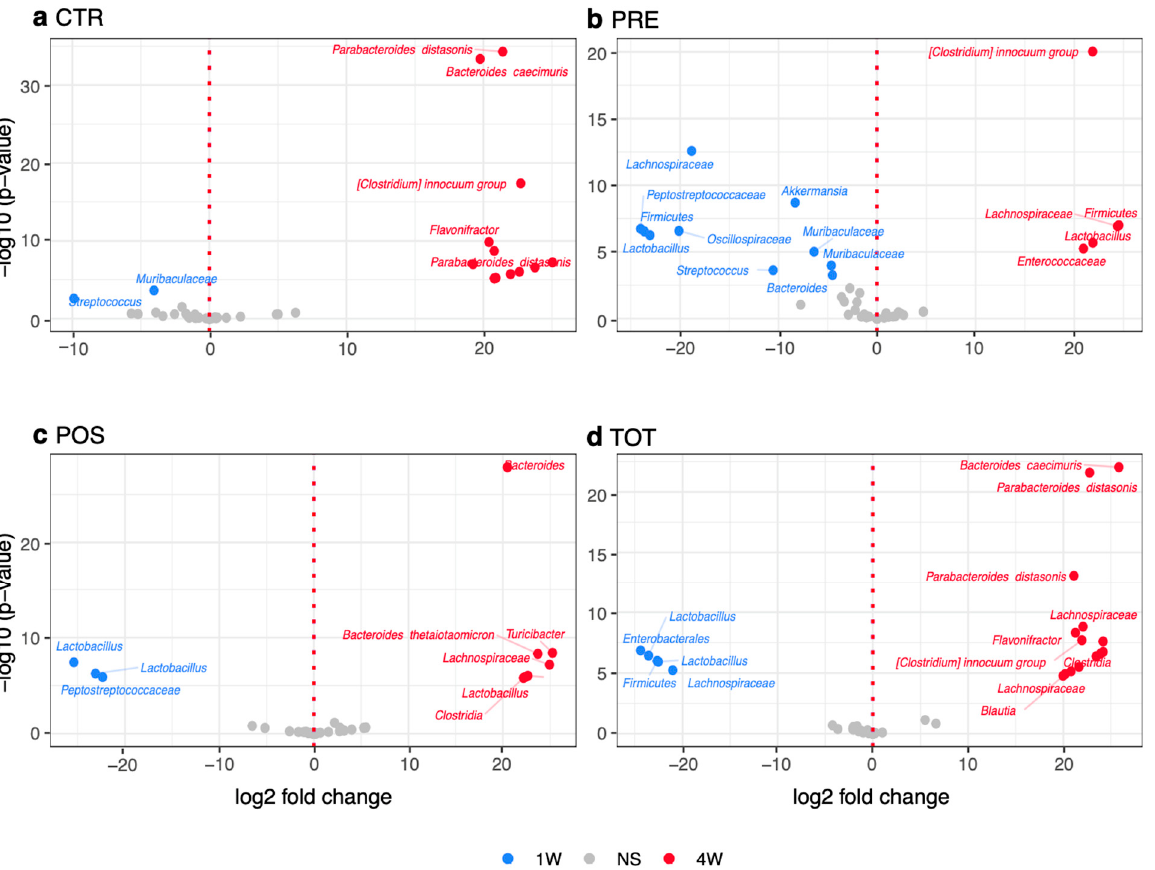
Figure 3. Volcano plots demonstrating significant differences ( p adj. < 0.05) in relative abundance of microbial taxa from W1 to W4. ( a ) CTR group volcano plot. ( b ) PRE group. ( c ) POS group volcano plot. ( d ) TOT group volcano plot. NS represents values that are not significant.